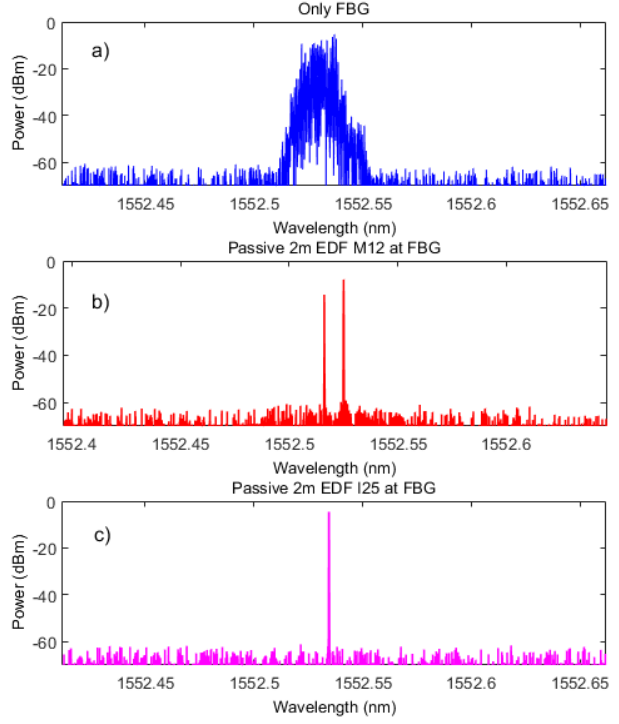
Figure 4. High-resolution output spectra of the EDSCL measured by a BOSA of each tested configuration: no passive EDF ( a ), 2 m of EDF M12 ( b ), or 2 m of EDF I25 ( c ) as passive element.